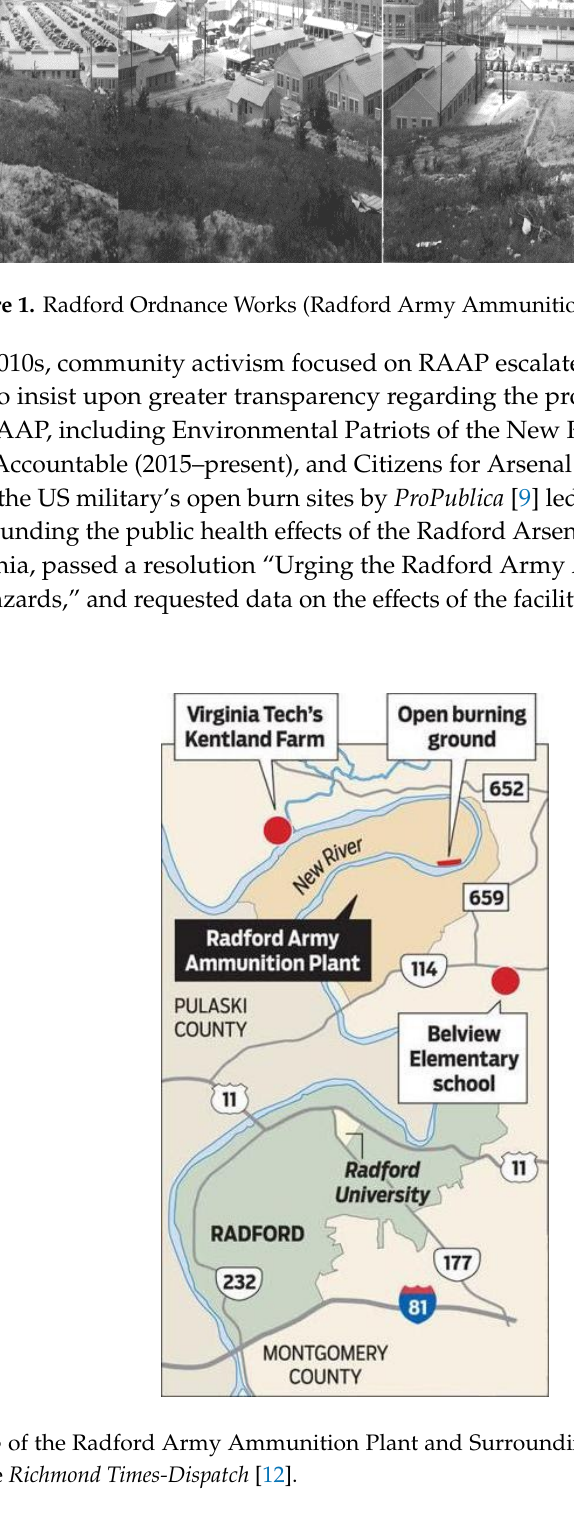
Figure 2. Map of the Radford Army Ammunition Plant and Surrounding Area. Image reproduced courtesy of the Richmond Times-Dispatch [12].